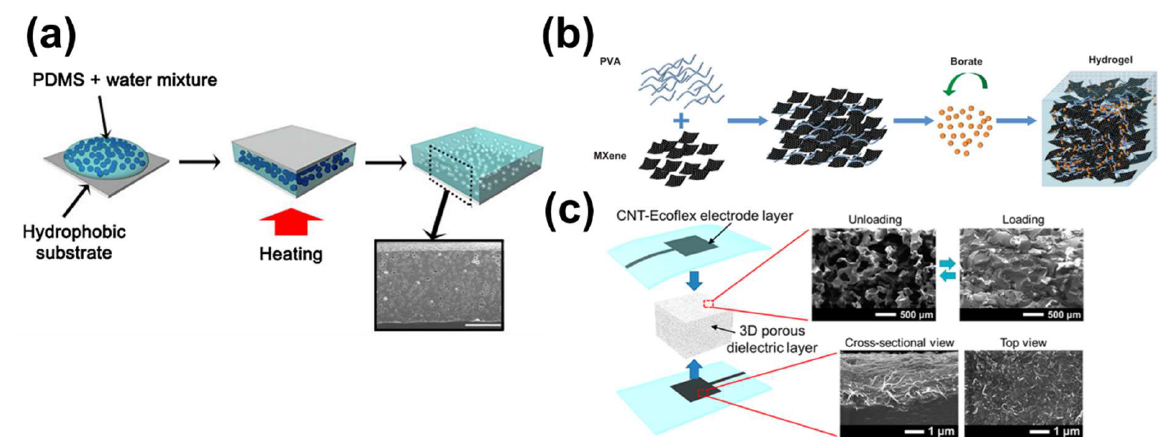
Figure 1. Schematic illustrations of fabrication processes. ( a ) An elastomer film with well-distributed micropores [51]. Copyright © 2021 Elsevier B.V. All rights reserved. ( b ) A MXene/PVA hydrogel electrode [45]. © 2021 WILEY-VCH Verlag GmbH & Co. KGaA, Weinheim. ( c ) A CNT/Ecoflex ® nanocomposite film electrode layer and a microporous Ecoflex ® dielectric layer between them [52]. Copyright © 2021, American Chemical Society.